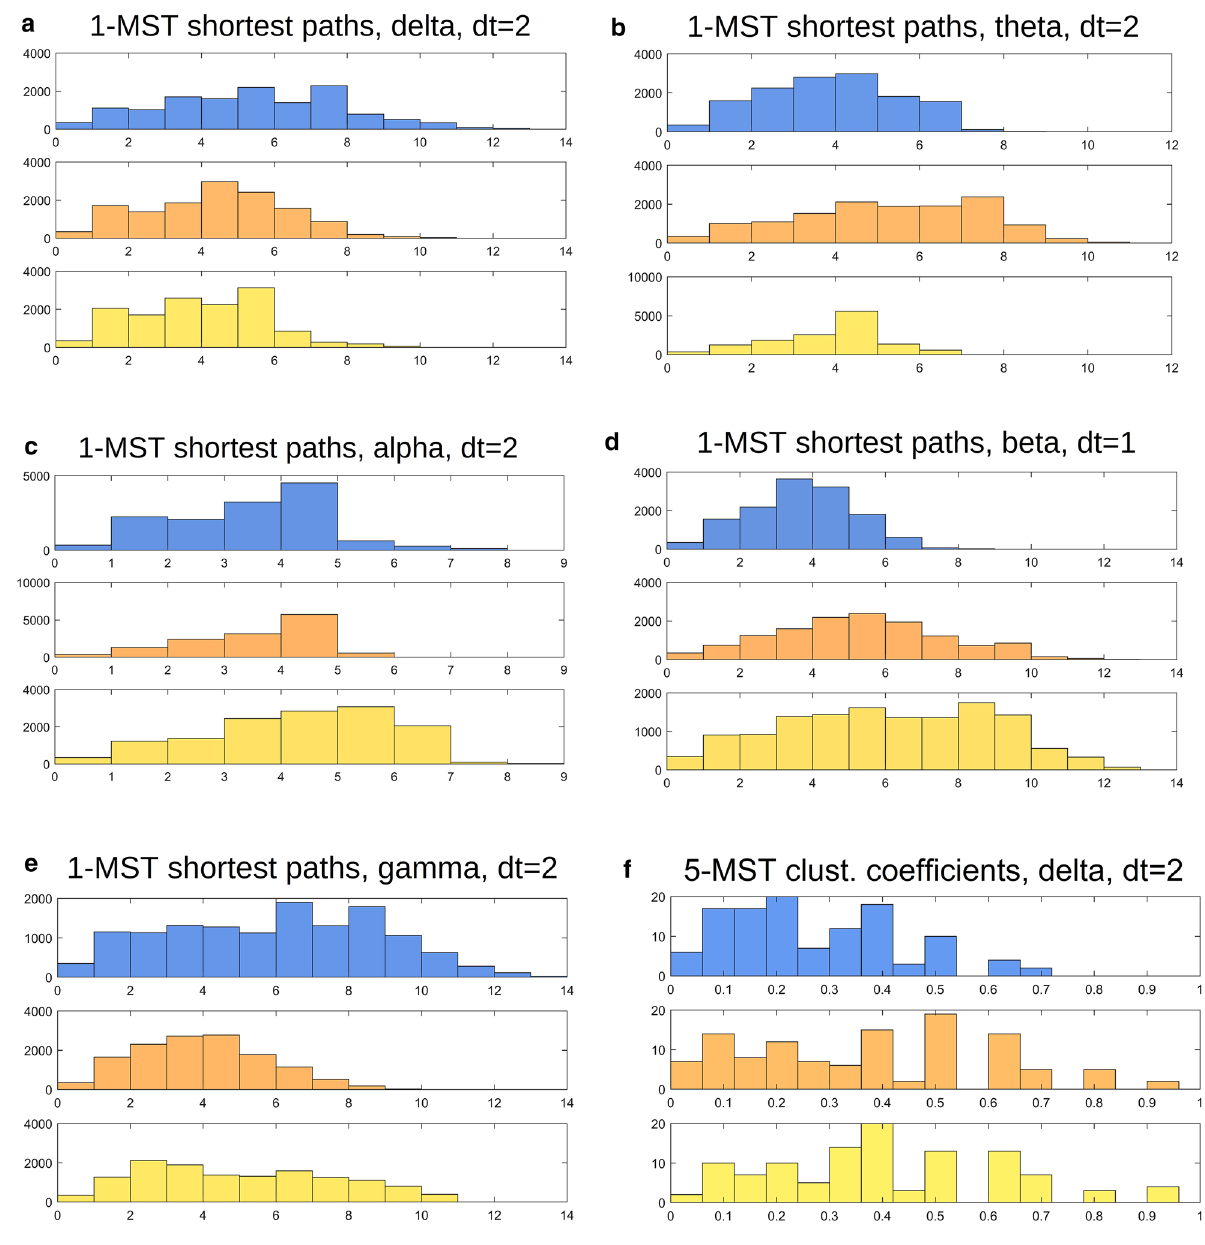
Figure 2. Histograms of MST shortest-path-length and clustering coefficient histograms (left and right columns, respectively) for the five combinations of time-offset and frequency band that show particularly strong changes in distribution with disease class (delta, dt = 2; theta, dt = 2; alpha, dt = 2; beta, dt = 1; gamma, dt = 2). Beta (and to a lesser extent alpha) shows a steady increase in the overall path-length with disease severity, along with increased variance. Delta, by contrast, shows decreasing path-length and variance with severity. Trends for clustering coefficients tend to be roughly inverse to those in